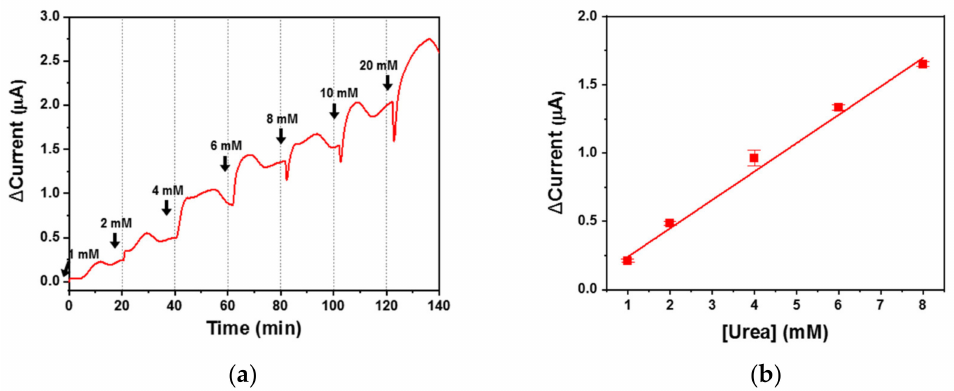
Figure 6. ( a ) Real-time monitoring of urea-spiked human serum using the urea biosensors under flow conditions and ( b ) the biosensor response according to changing urea concentration with linear fitting.